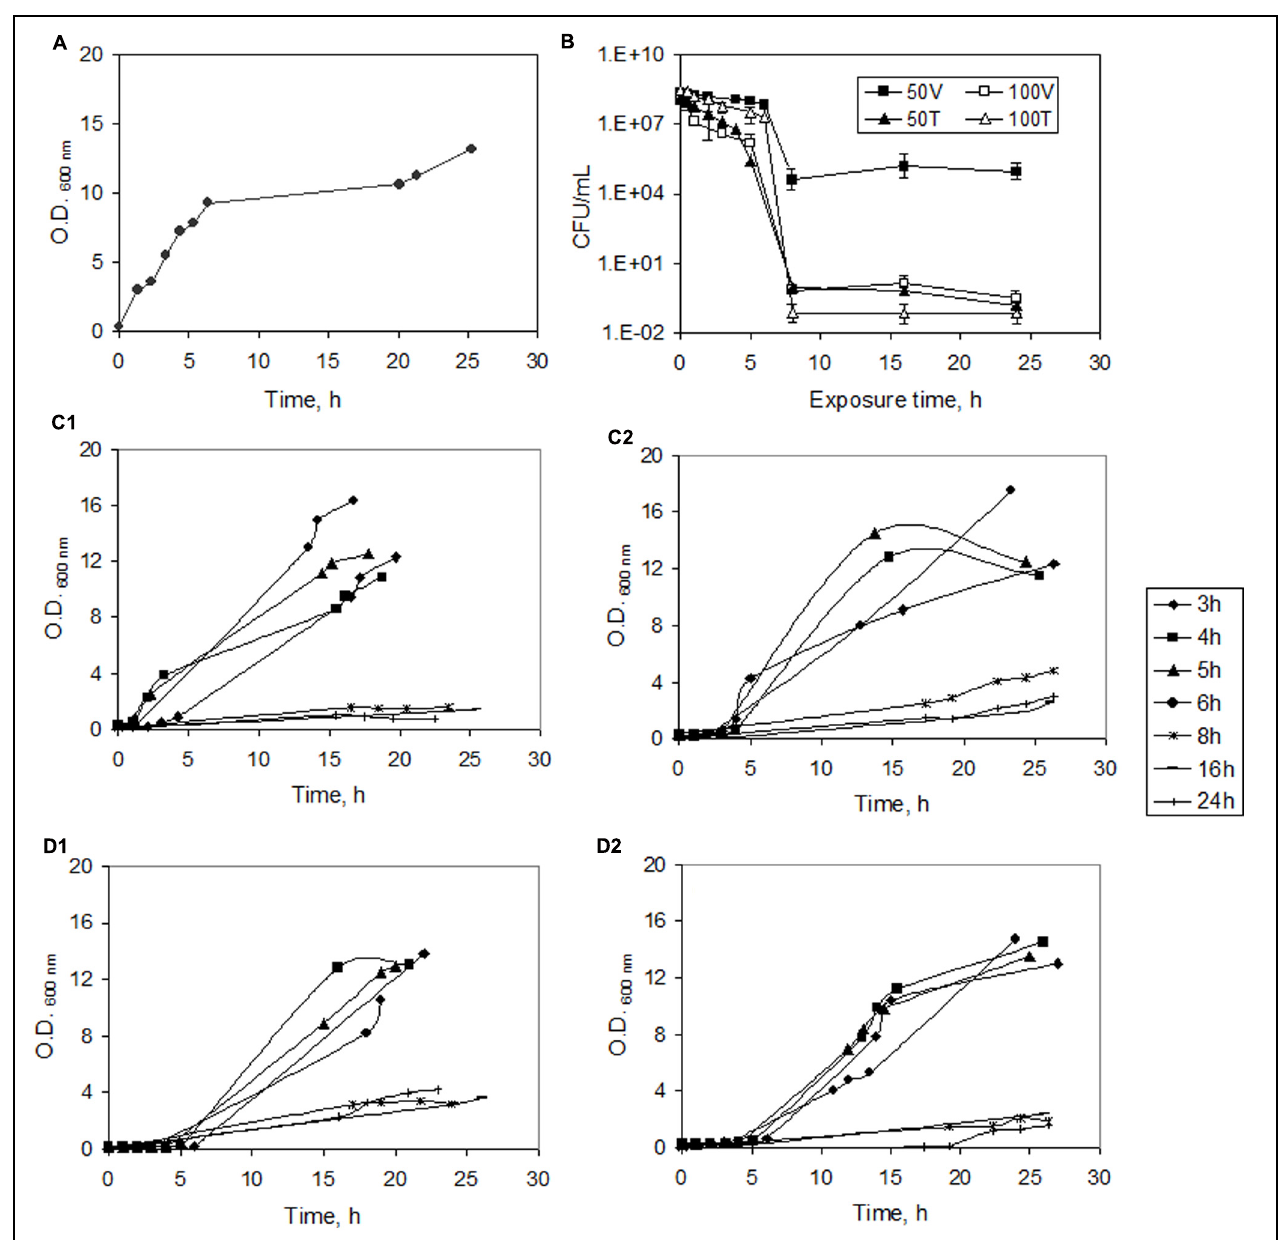
FIGURE 1 | Inducing persister formation in Staphylococcus aureus . (A) Growth curve of normal cells in MHB. (B) Time-dependent killing curve during exposure to 50 and 100 mg/L of vancomycin (V) and teicoplanin (T). The CFU/mL data are represented in logarithm scale. (C) Growth curves of S. aureus in fresh MHB after exposure to 50 (C1) and 100 (C2) mg/L vancomycin for 3, 4, 5, 6, 8, 16, and 24 h. (D) Growth curves of S. aureus in fresh MHB after exposure to 50 (D1) and 100 (D2) mg/L teicoplanin for 3, 4, 5 and 6, 8, 16, and 24 h. Error bars represent standard deviation